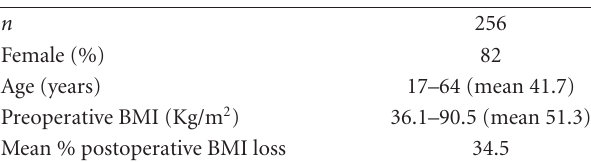
Table 1: Demographic data. Table 2: Preoperative percent change in body mass